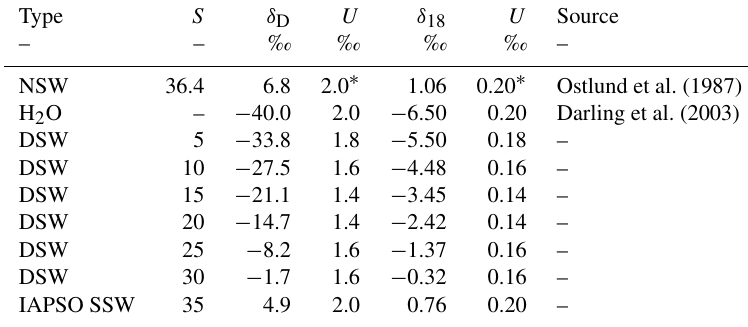
Table 2. Isotopic abundances of water and seawater (NSW – natural, DSW – diluted). Type